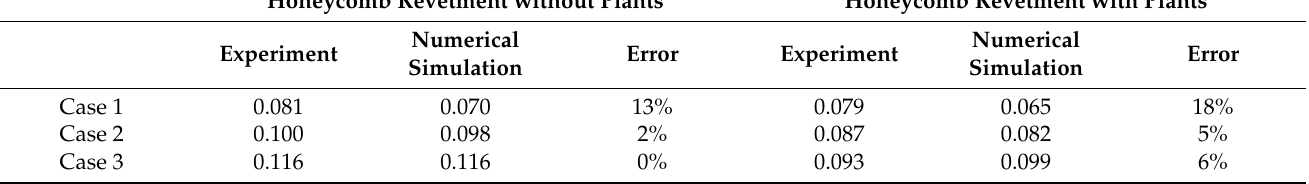
Table 2. Comparison between the run-up height of the experiments and that of the numerical simulation (Unit: